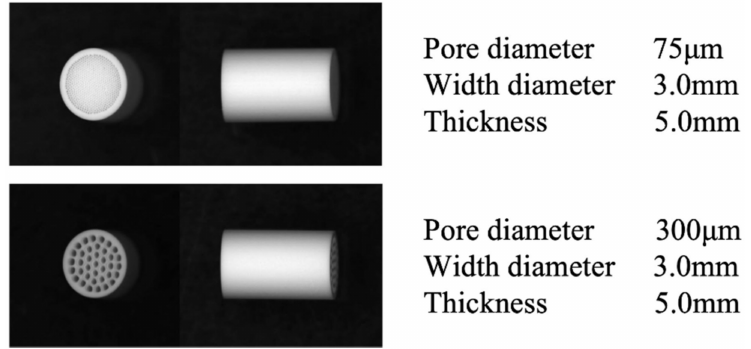
Figure 1. Honeycomb TCP structures used in the